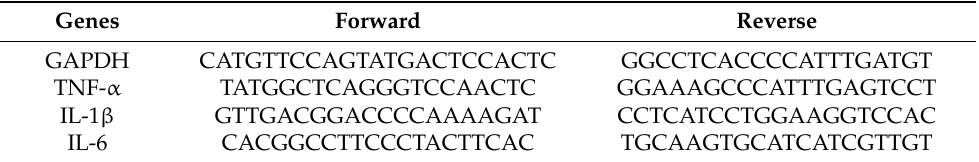
Table 2. RT-qPCR primer